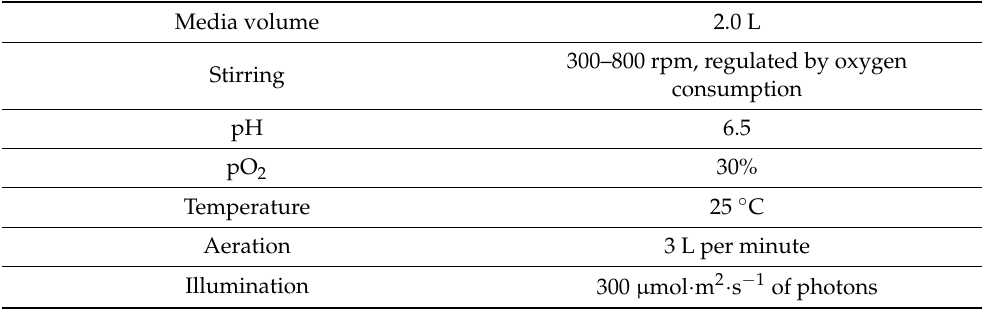
Table 1. Bioreactor process values during